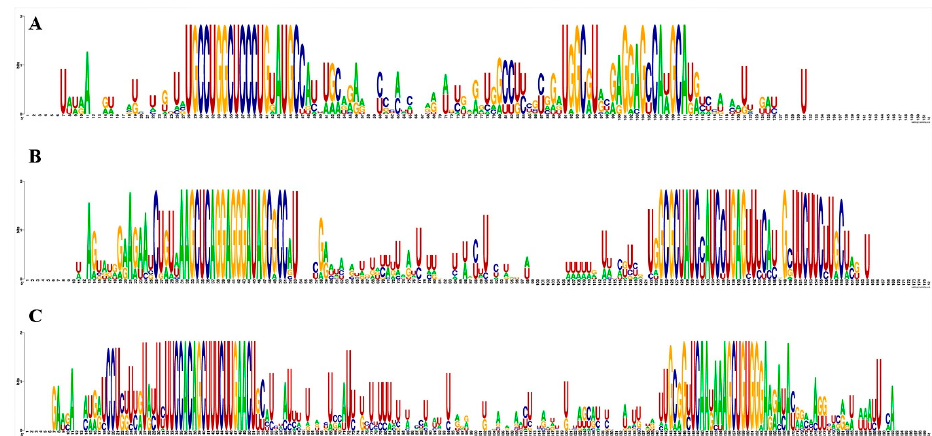
Figure 3. Conserved and nonconserved potential guava miRNA families (dark green boxes) and their homologs in other plant organisms. Identical color shades reflect closely related species, while filled and empty boxes indicate the presence or absence of miRNA families, respectively.